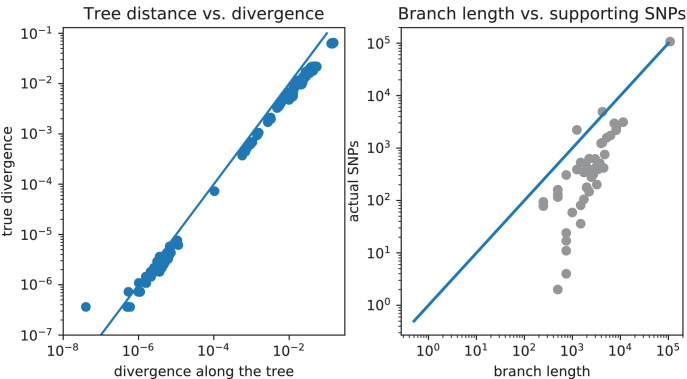
The pairwise distances and number of SNPs on each branch as predicted by the core tree do not match the pairwise distances and SNP numbers observed in the data.Comparison of pairwise distances and number of SNPs on each branch as predicted by the core tree, with pairwise distances and SNP numbers observed in the data. Left panel: Scatter plot of the pairwise divergences along the core tree (horizontal axis) versus the observed pairwise divergences (vertical axis). Right panel: For each branch of the tree, the total number of SNPs predicted to fall on the branch, that is the probability of a substitution to occur along the branch times the number of columns in the alignment, is shown (horizontal axis) against the actual number of SNPs in the data that fall on the branch. All axes are shown on logarithmic scales.